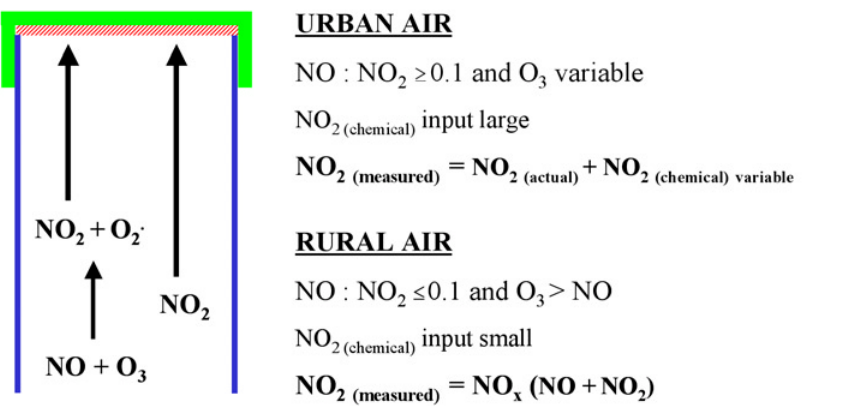
FIGURE 3: Sampling artefact due to ‘within-tube’ chemical reaction leading to formation of ‘additional’ NO 2